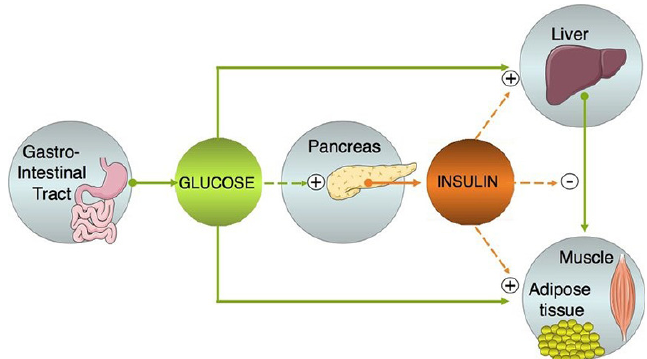
Figure 1. High-level representation of the glucose-insulin control system (Reprinted with permission from [4]; published by Mary Ann Liebert, Inc., New Rochelle, NY, USA,